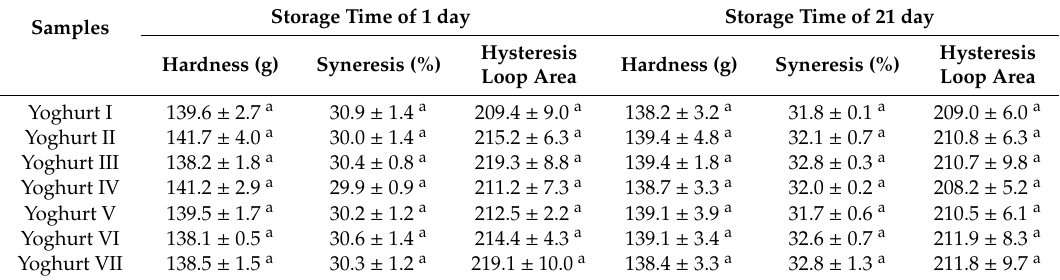
Table 3. Hardness and syneresis of Yoghurts I–VII after storage of 1 and 21 day at 4 ◦ C. Samples